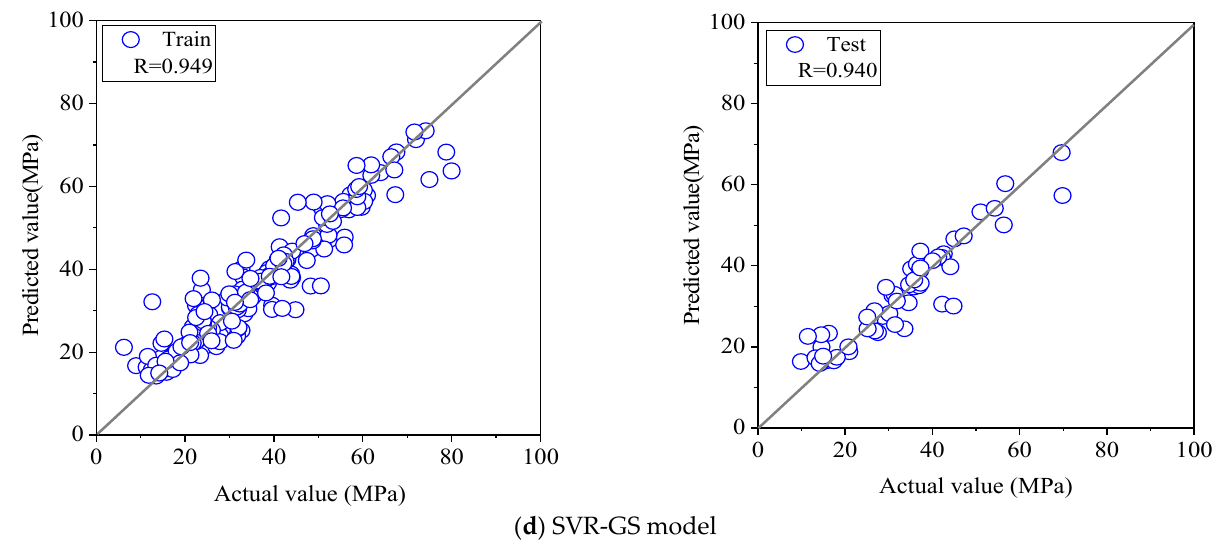
Figure 7. Scatter plot of the prediction results of the four models. Figure 8 shows a comparison of the expected and actual values for each sample for a more intuitive presentation, and the error metrics for model training and testing are shown in Figure 9. It can be observed that for both the training and test sets, the highest values for RMSE, MSE, MAPE, and MAPE were recognized by the ELM model, while the hybrid SVR ‐ GS model achieved the highest prediction accuracy in terms of the lowest RMSE = 4.814, MSE = 23.177, MAPE = 3.432, and MAPE = 13.818%. Compared with the average relative errors of 23.71%, 16.51, and 16.17% for the ELM, random forest, and SVR models, respectively, the optimized model achieved the smallest average relative error of 13.82%, which was less than 15%. This shows that the prediction accuracy of the SVR ‐ GS model can basically meet the engineering requirements and could serve as an efficient alternative method to predict the compressive strength of fly ash concrete.